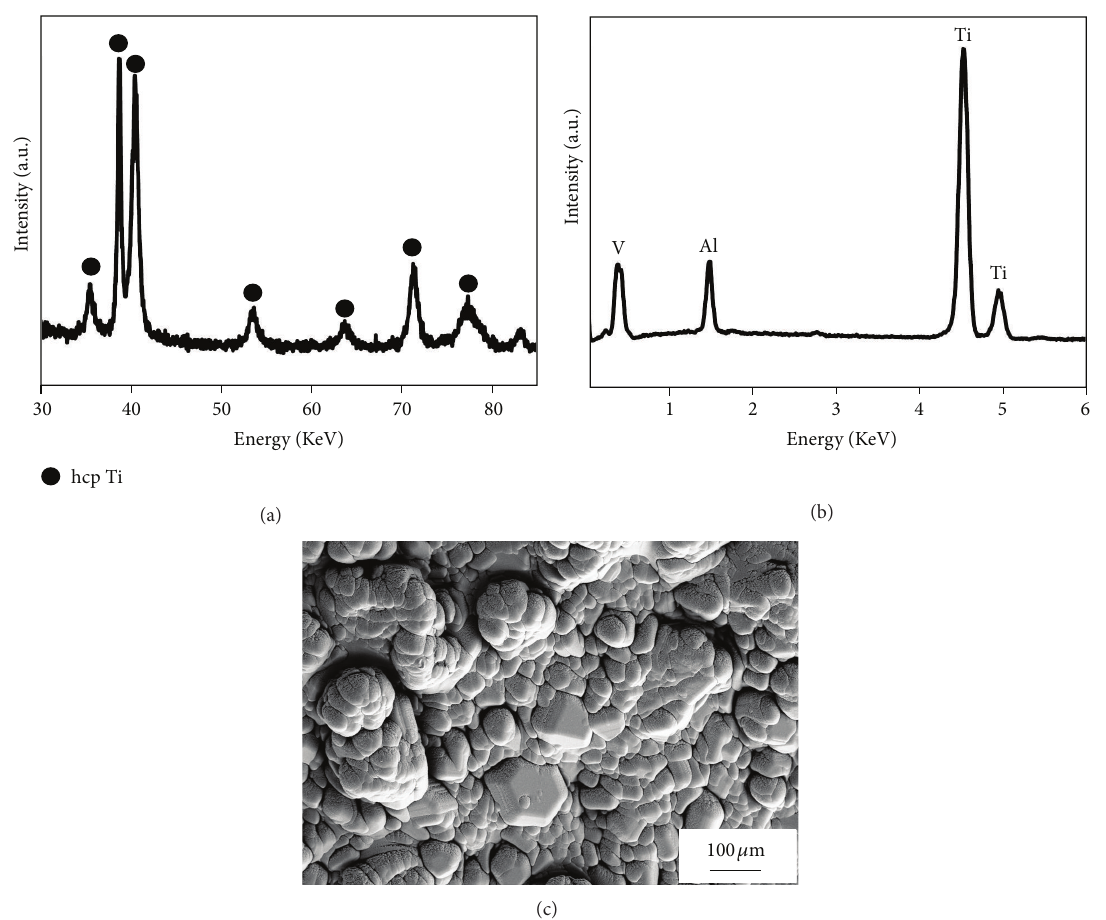
Figure 4: (a) XRD pattern, (b) EDS result, and (c) SEM micrograph of the Ti6Al4V